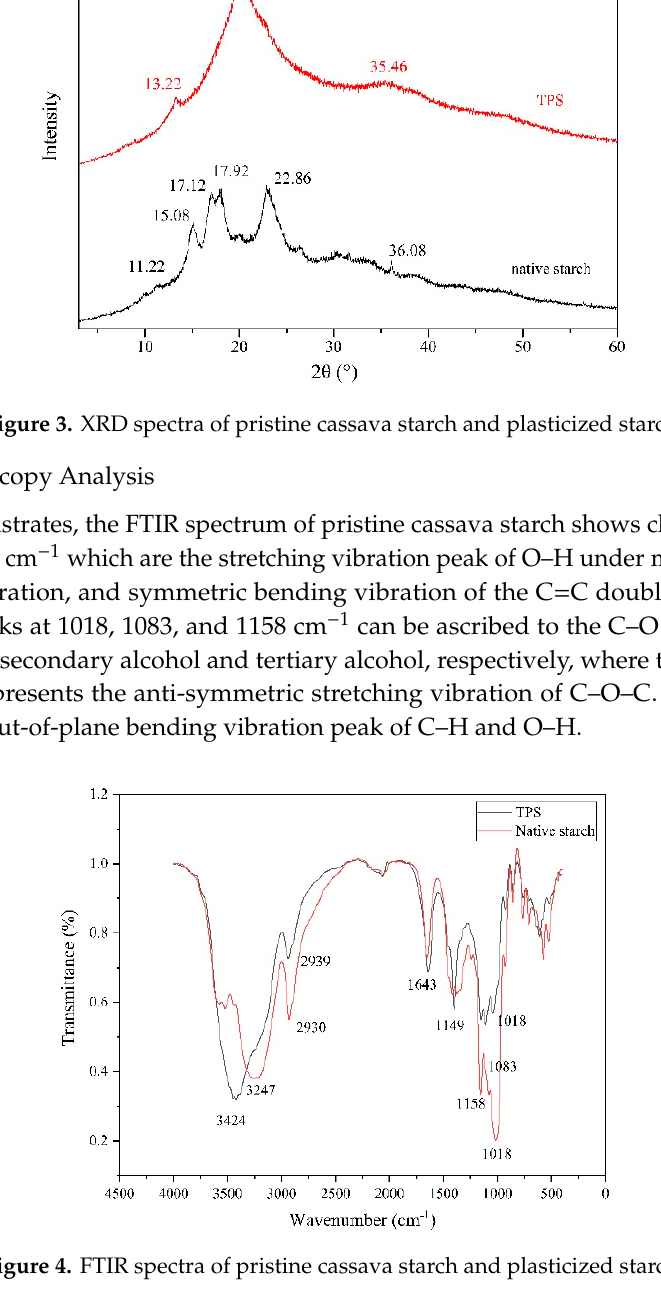
Figure 3. XRD spectra of pristine cassava starch and plasticized starch.